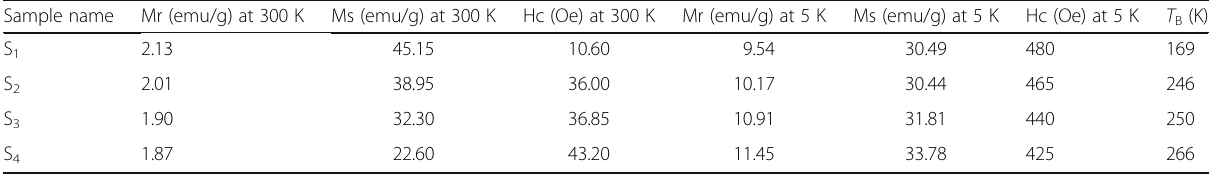
Table 1 Some useful parameters of M-T and M-H